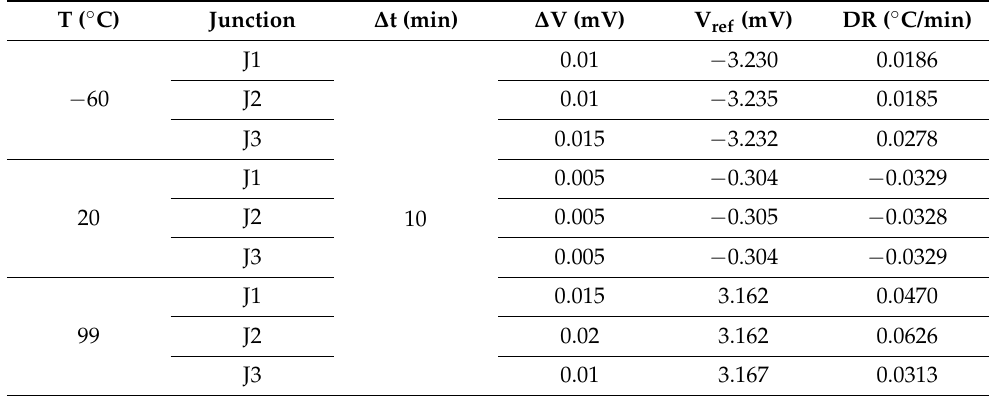
Table 5. The drift rate of three junctions at three different